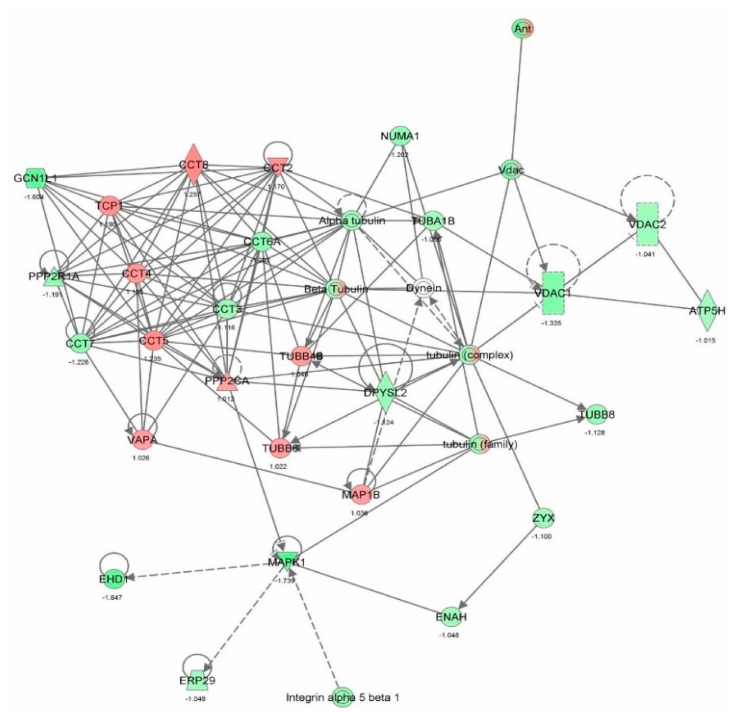
Figure 6. Vancomycin regulated cellular assembly and organization, cell-to-cell signaling and interaction, and reproductive system development and function. Red indicates an up-regulation; green indicates a down-regulation. The intensity of green and red colors indicates the degree of down- or up-regulation. Solid arrow indicates direct interaction and dashed arrow indicates indirect interaction.